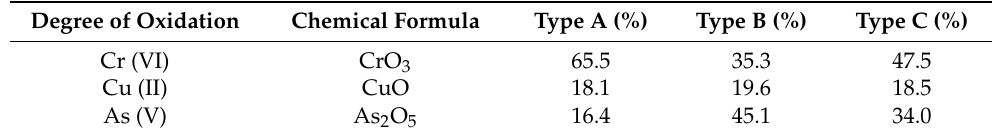
Table 1. Different types of CCA formulation